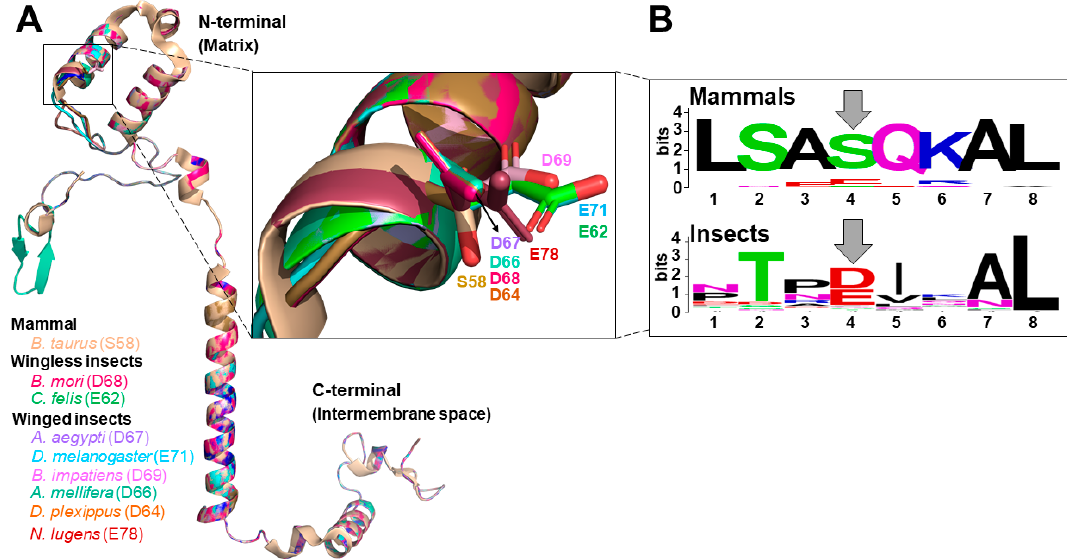
Figure 2. The tridimensional structure models of insects COXIV. ( A ) Overlay of eight structures of COXIV from insects modeled using the Phyre 2 server, using the primary sequence as input, normal modeling mode and the Bos taurus crystal structure (PDB: 1V54) as a template [171]. All structures were aligned from the mitochondrial matrix N-terminal on the top to the C-terminal at the intermembrane space at the bottom. The structures were analyzed using Pymol software and colored as shown in the figure. The conserved Asp (D) and Glu (E) residues in the α 1-helix of insects COXIV are highlighted and shown in the inset box. Note that the only Ser residue (Ser58) identified is from B. taurus . ( B ) WebLogo diagram of α 1-helix region close to mammalian Ser58 identified by the grey arrow. WebLogos of other insect COXIV regions containing known P-sites [172] are identified by the grey arrow. The WebLogos used the multiple alignment from 22 sequences from 19 mammals and 38 sequences of 21 insect species. Note the conserved Ser residue in the position 4 for mammals, equivalent to Ser58 [150], while for most insects this residue is exchanged for a Glu or Asp at the same